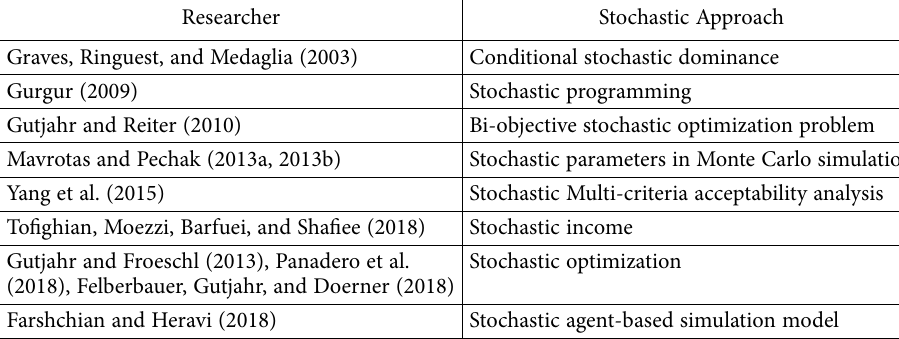
Table 9. Reviewing studies with stochastic tools Researcher Stochastic Approach Graves, Ringuest, and Medaglia (2003) Conditional stochastic dominance Gurgur (2009) Stochastic programming Gutjahr and Reiter (2010) Bi-objective stochastic optimization problem Mavrotas and Pechak (2013a, 2013b) Stochastic parameters in Monte Carlo simulation Yang et al. (2015) Stochastic Multi-criteria acceptability analysis Tofighian, Moezzi, Barfuei, and Shafiee (2018) Stochastic income Gutjahr and Froeschl (2013), Panadero et al. Stochastic optimization (2018), Felberbauer, Gutjahr, and Doerner (2018) Farshchian and Heravi (2018) Stochastic agent-based simulation